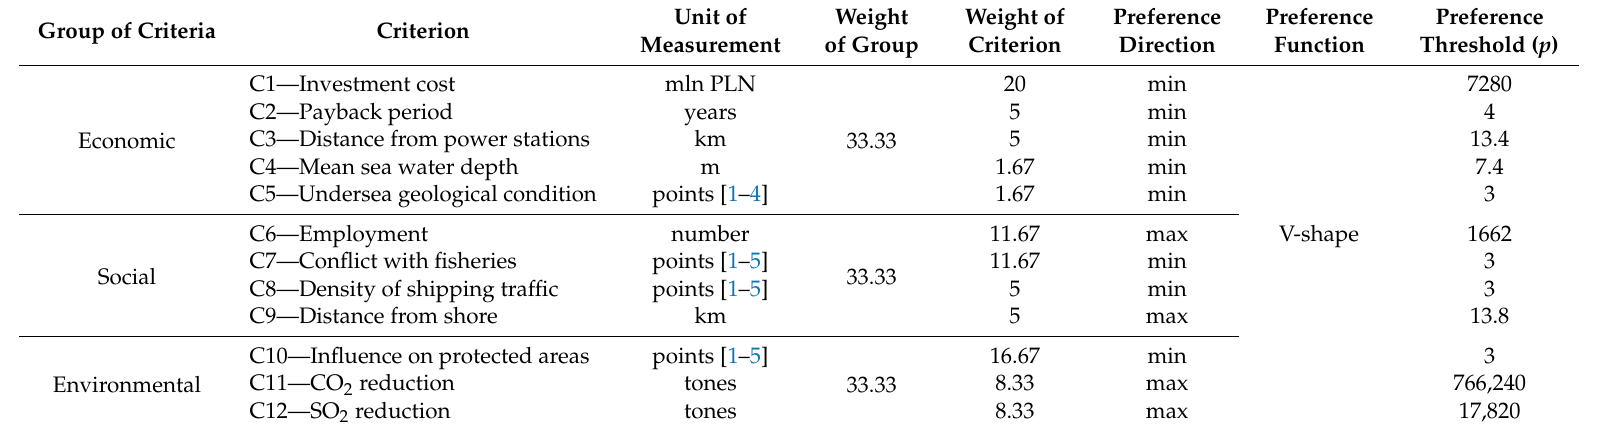
Table 4. The preference model used in the problem of location selection for an offshore wind farm in Poland.